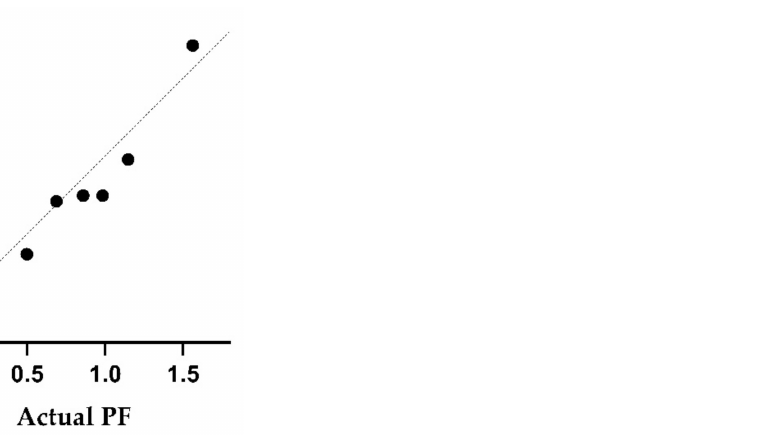
Figure 3. Predicted processing factor (PF) for pesticides in white wines in correlation with measured values. For the multiple linear regression, the log K OW was taken into account and whether fining was carried out during winemaking.